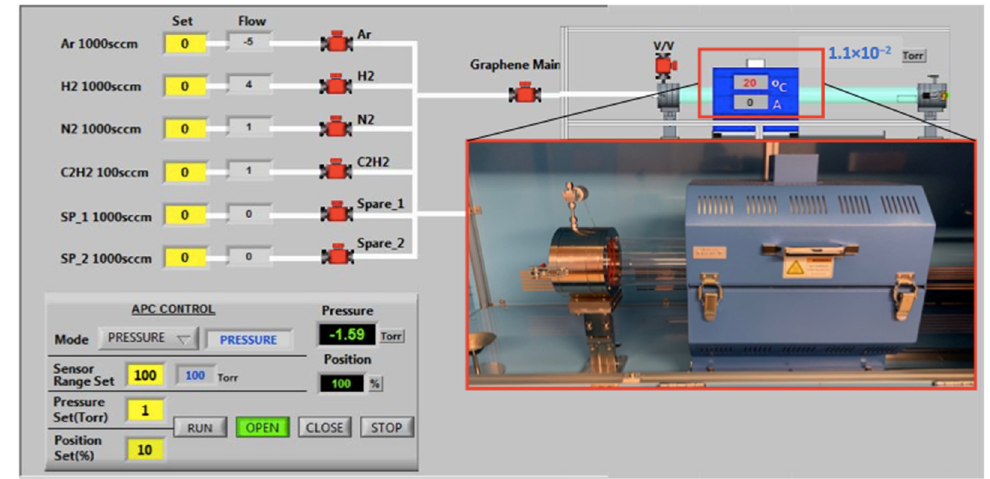
Figure 1. Chemical vapor deposition setup for carbon nanotube fabrication.